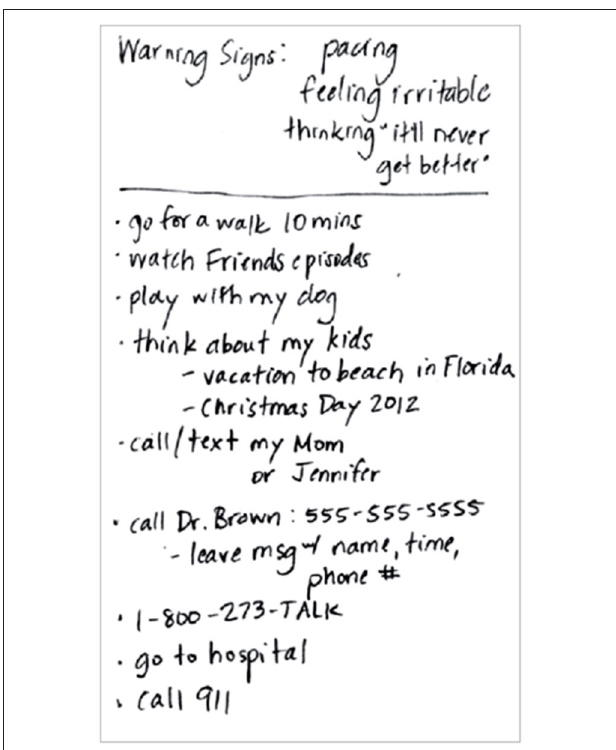
FIGURE 1 | Example crisis response plan (9).